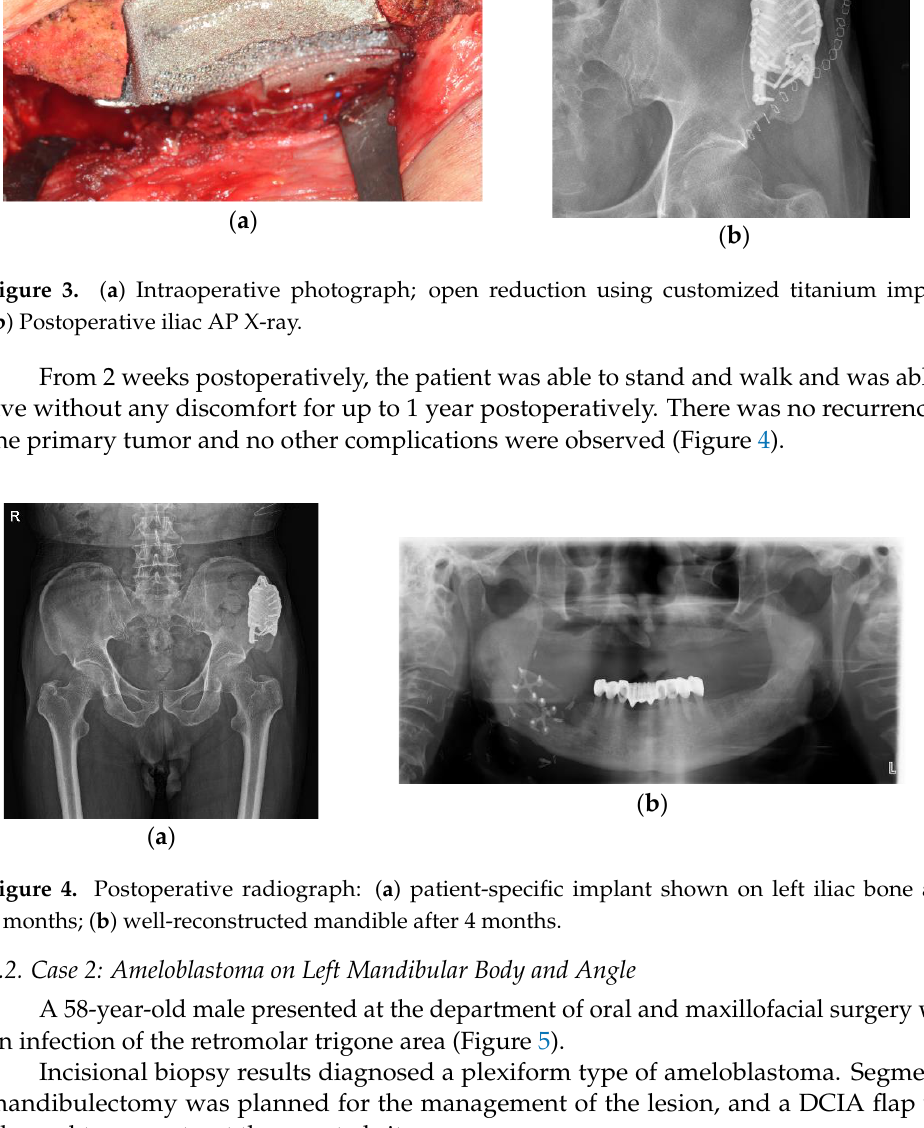
Figure 2. ( a ) Fractured iliac bone; ( b , c ) computer-based planning and designed titanium implant.